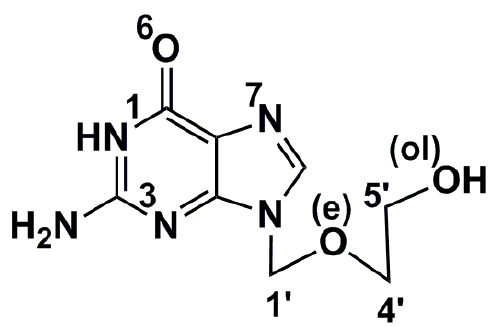
Figure 1. Formula of acyclovir and the numbering used in this work (see also Figure A1).